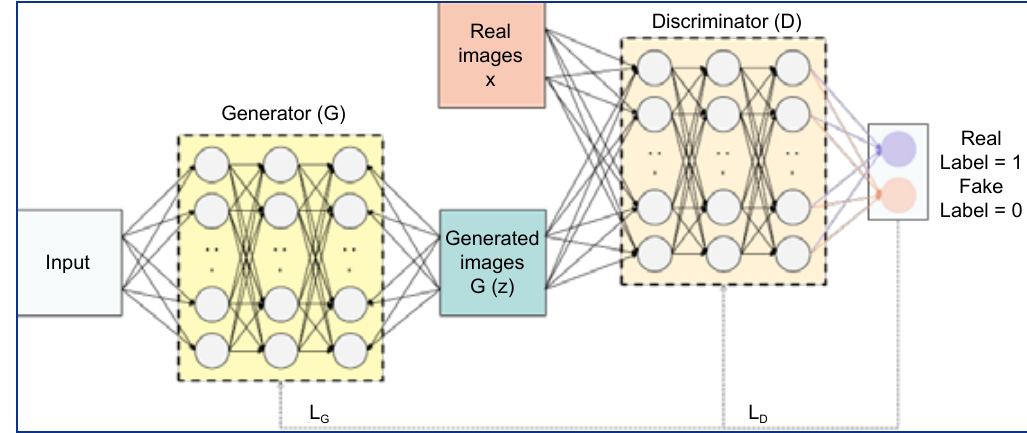
Figure 3 The basic architecture of GAN. L G and L D express the loss functions of the generator and discriminator,